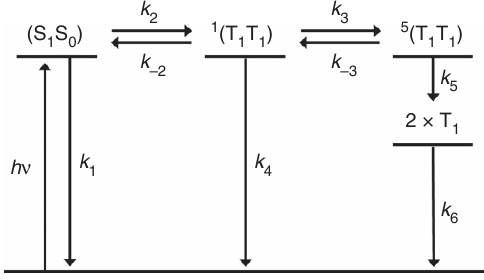
Figure 3 | Kinetic model. Kinetic model used to fit both the transient optical absorption and TREPR data for NC in both benzonitrile at 295K and butyronitrile at 105K.